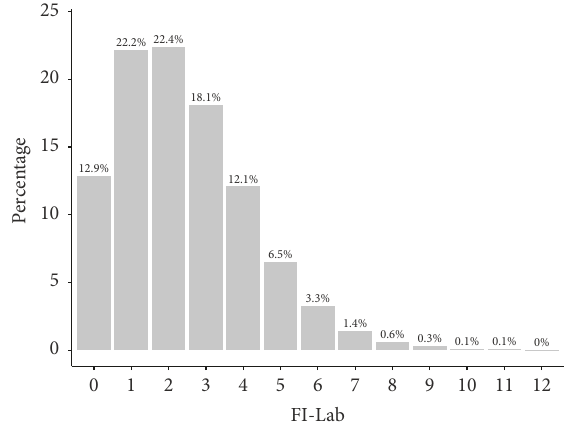
Figure 2: Distribution of FI-Lab across study